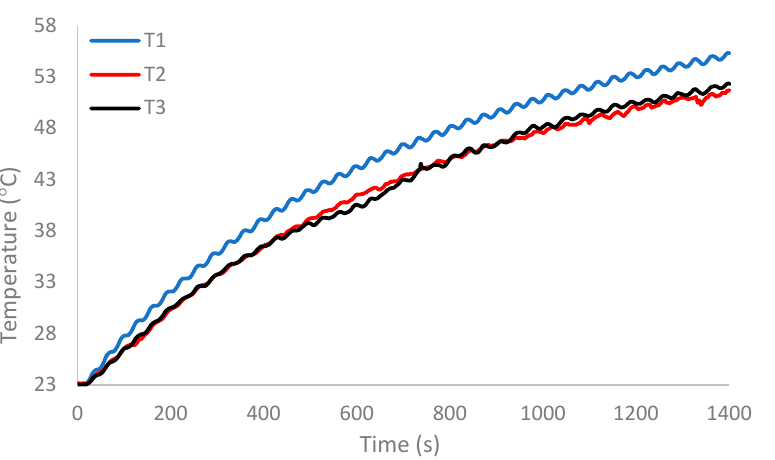
Figure 4. The temperature variation of the LiC cell under NC at 23 °C initial temperature and 150 A charge/discharge current rate.